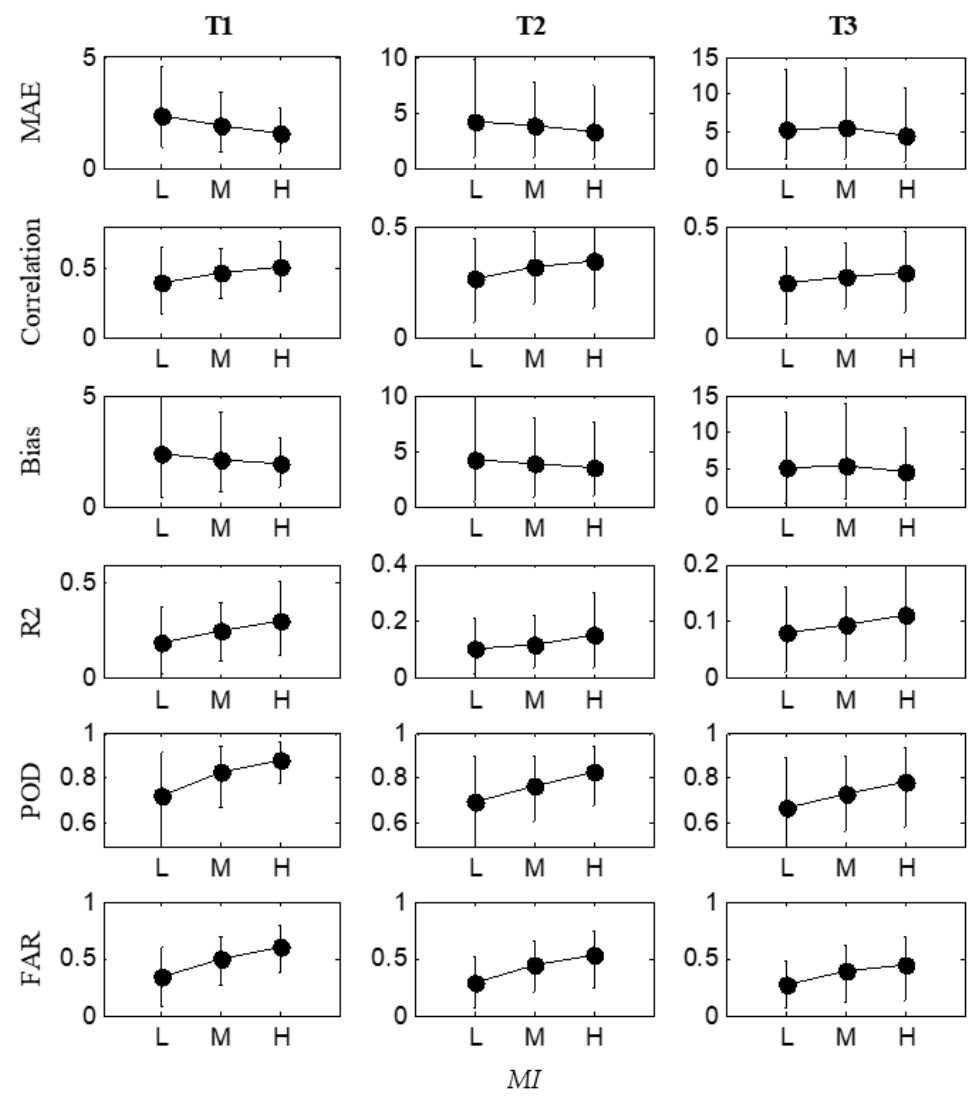
Figure 5. Relationship between rainfall nowcasting skill and rainfall spatial Moran’s I values. The error bars show the largest and lowest values in each subset events, while the markers represent the corresponding averaged values.